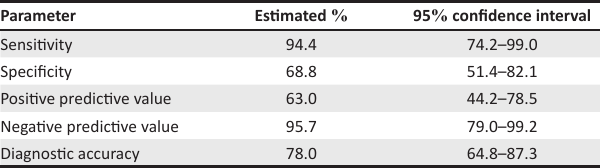
TABLE 2: Diagnostic evaluation of the contrast enema compared to rectal biopsy as the gold standard. Parameter